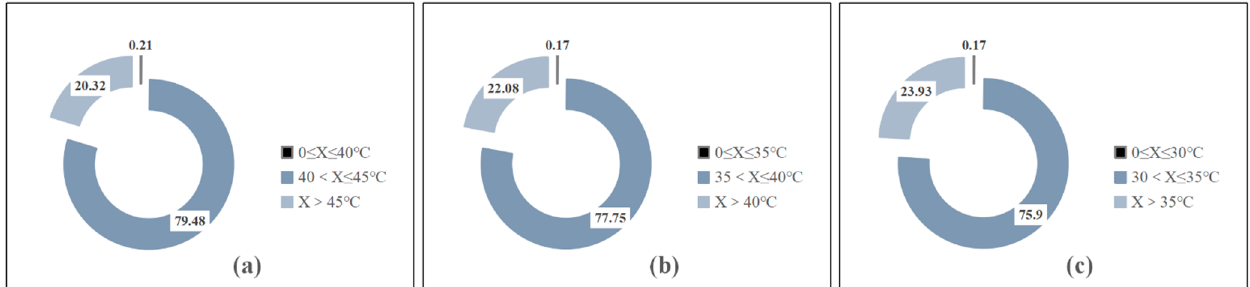
Figure 5. The proportion of the temperature of the HSWT under different designed water supply temperatures: ( a ) 45 °C ; ( b ) 40 °C ; ( c ) 35 °C .